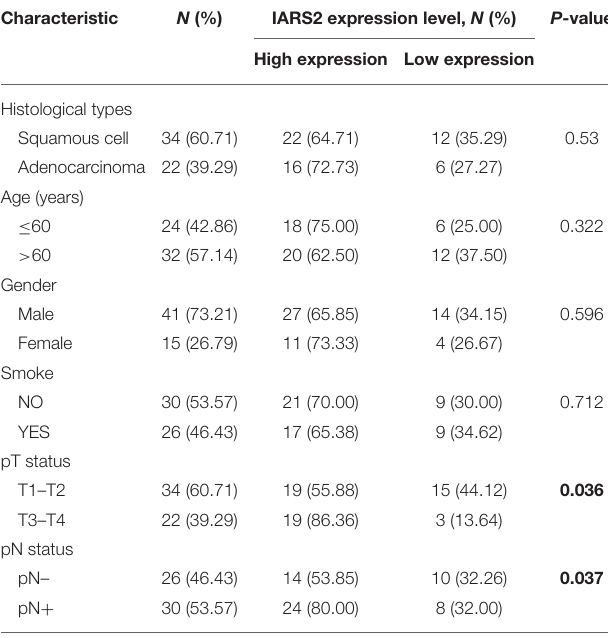
TABLE 1 | Association of IARS2 with clinicopathological characteristics from 56 lung cancer patients.